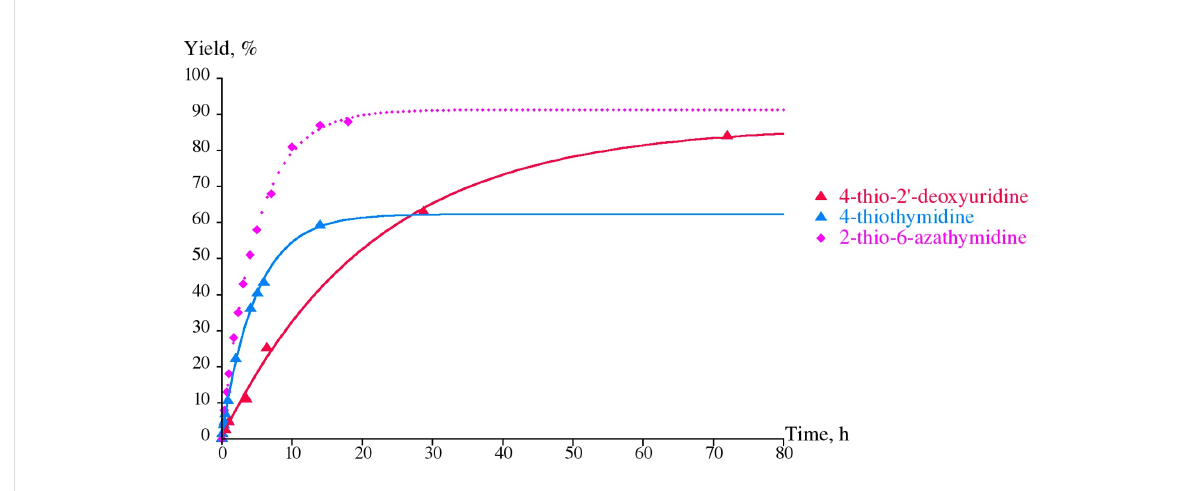
Figure 4: Phosphorolysis of 6-aza-2-thiothymidine ( 5b ), 4-thiothymidine ( 11a ) and 4-thio-2 ′ -deoxyuridine ( 1b ) by E. coli TP for extended time period (for details, see caption of Figure 2).